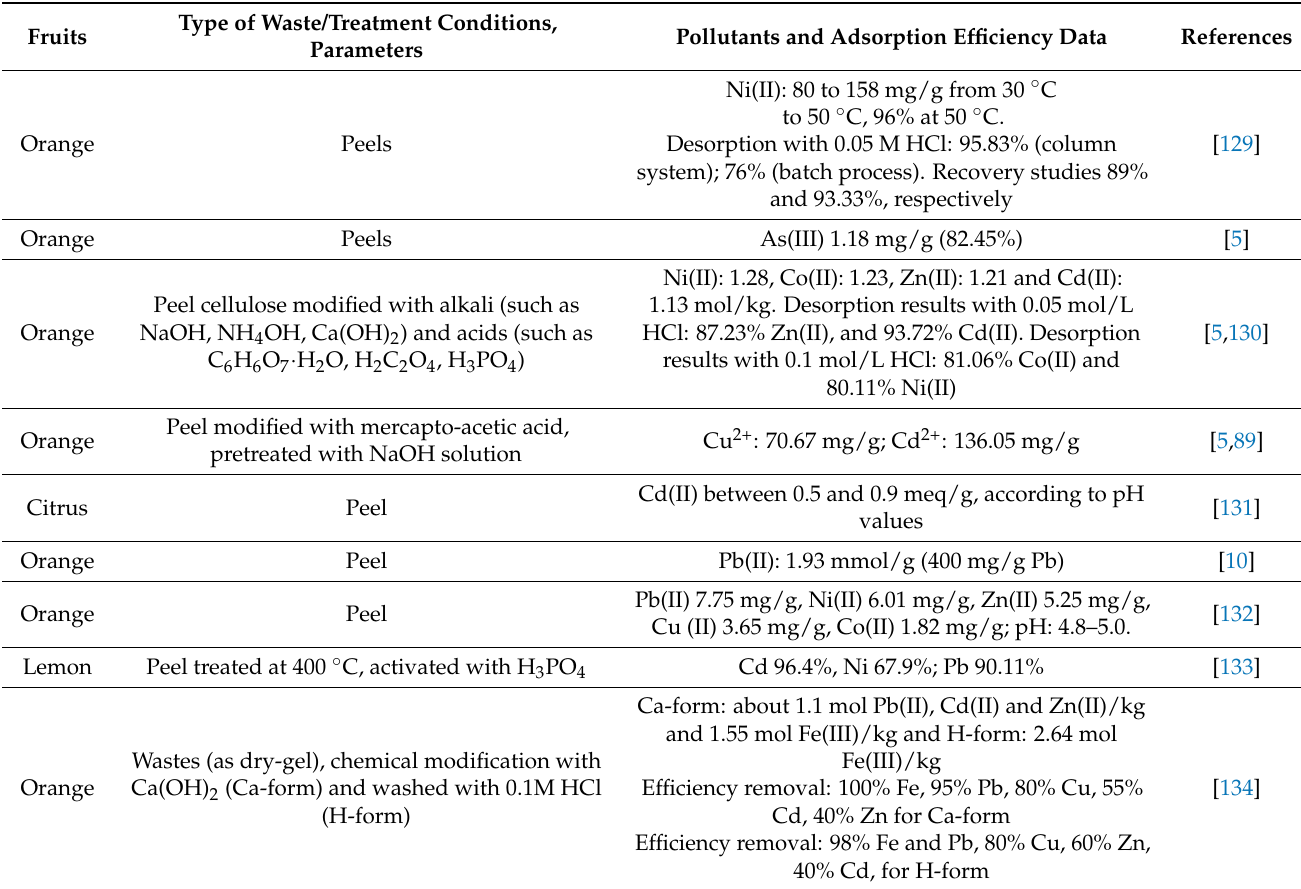
Table 3. Examples of use of vegetable wastes as adsorbents for water